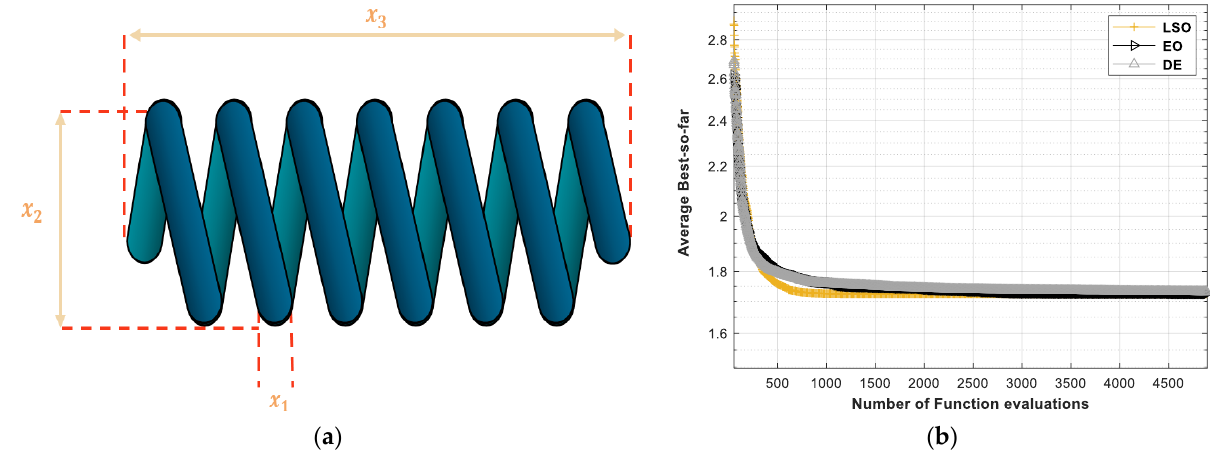
Figure 21. Tension/compression spring design problem. ( a ) Structure. ( b ) Convergence curve. Table 17. Comparison of the results for tension/compression spring design optimization problem.